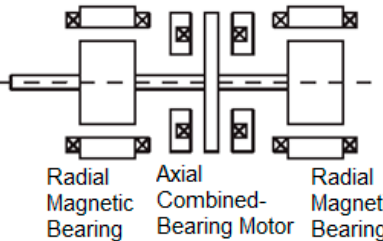
Figure 2. Structure of axial combined magnetic bearing motor.